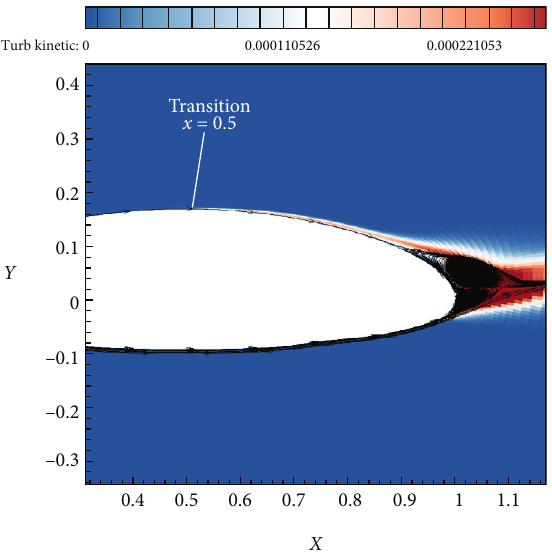
Figure 34: Turbulent kinetic energy distribution of DBLN-526 airfoil ( Re = 0 : 8 E 6 , α = 10 °